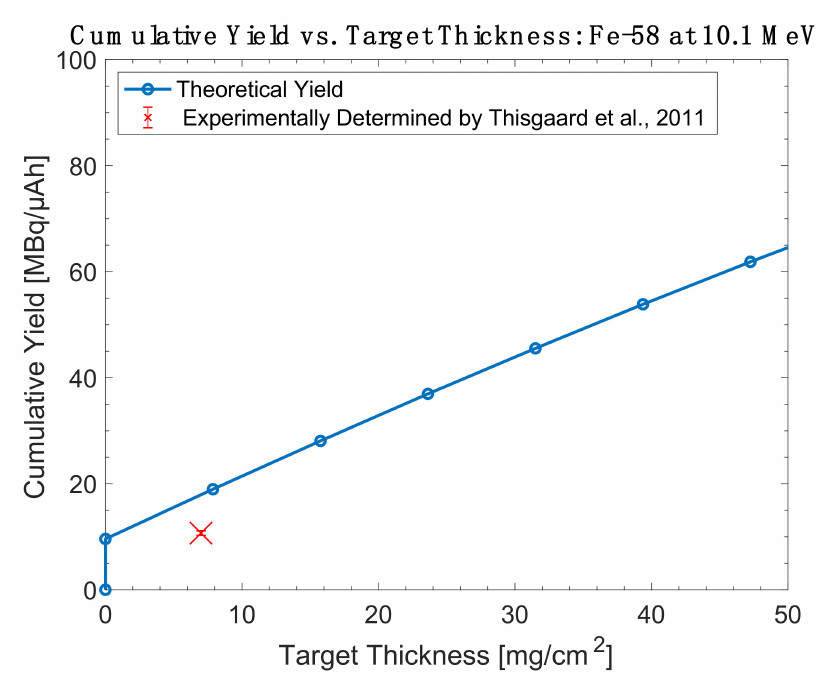
Figure 16. Thick target yield comparison between theoretical data and experimentally collected data for iron-58 targets at 10.1 MeV [87].